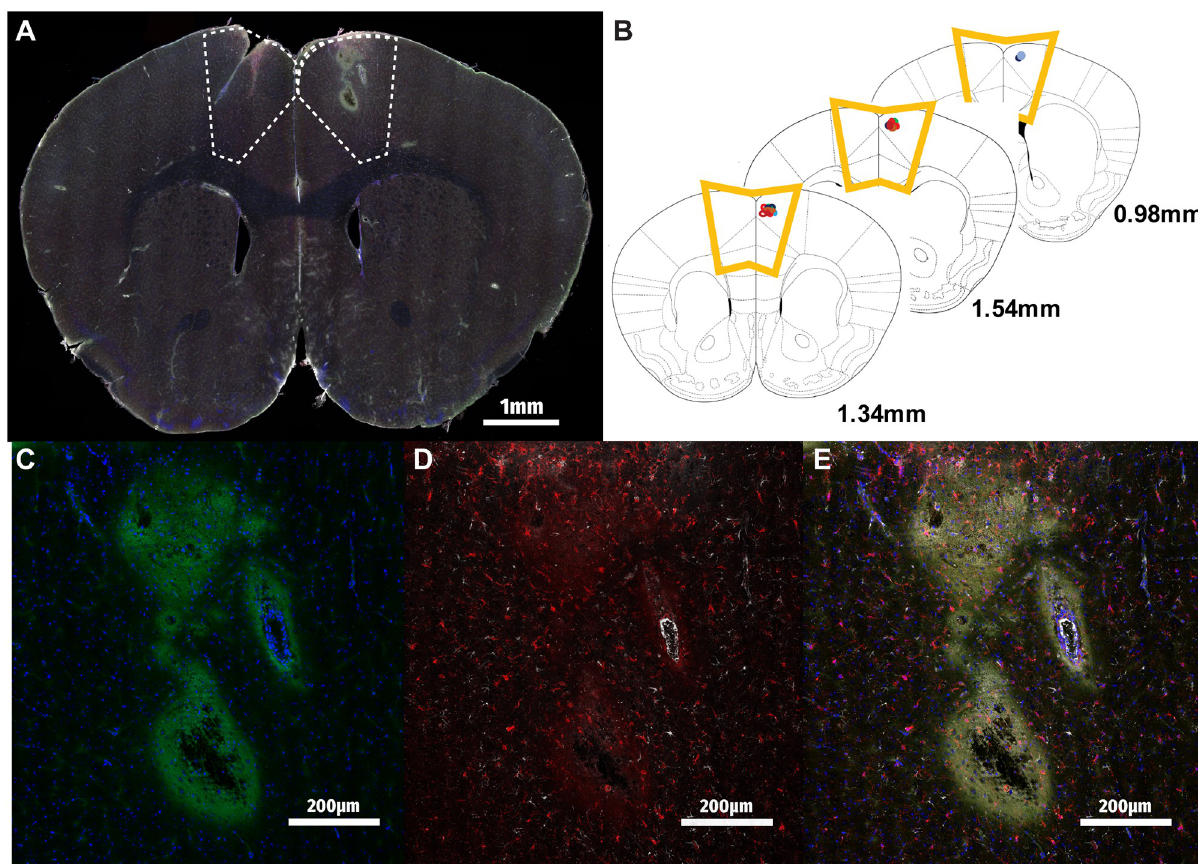
Fig 3. Detection of radioluminescent particles in mouse motor cortex. A) Tile-scanned merge of RLP-injected mouse brain at 40x zoom DAPI (blue), RLPs (green), IBA-1 (red) and GFAP (white). M2 region highlighted with dotted line. B) Overlay of RLP injection sites determined by sectioning M2 region of n = 12 animals demonstrates highly reproducible localization of RLP delivery. C) RLP injection site inset demonstrates fluorescein signal near the injection site. D) IBA-1 expressing microglia and GFAP-expressing astrocytes are detectable by the injection site 24 hours post-injection. E) RLP and cellular markers